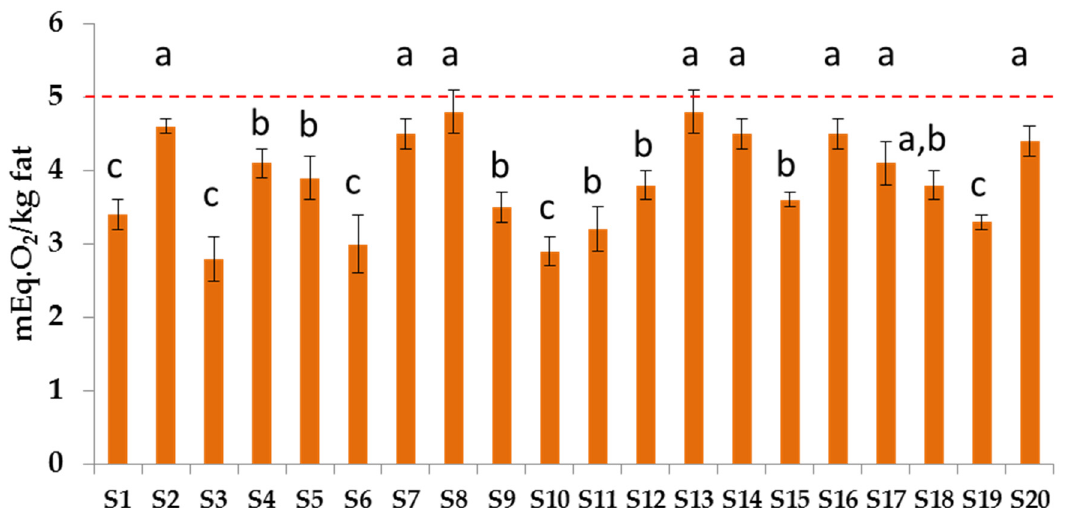
Figure 6. Peroxide values (PV) of oil of supplements (red dotted line indicates the GOED maximum limit of 5 mEq. O 2 /kg). Error bars present the standard deviation ( n = 3). Different letters report on the statistical differences ( p < 0.05).